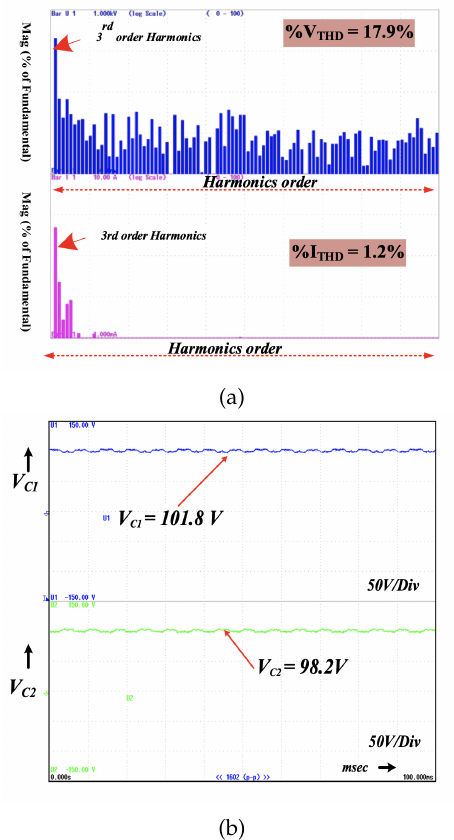
Fig. 10. Experimental results: (a) Line voltage and Phase current voltage harmonics spectrum, (b) NPC-MLI DC-link Capacitors voltage V C1 and V C2 , [50V/div]